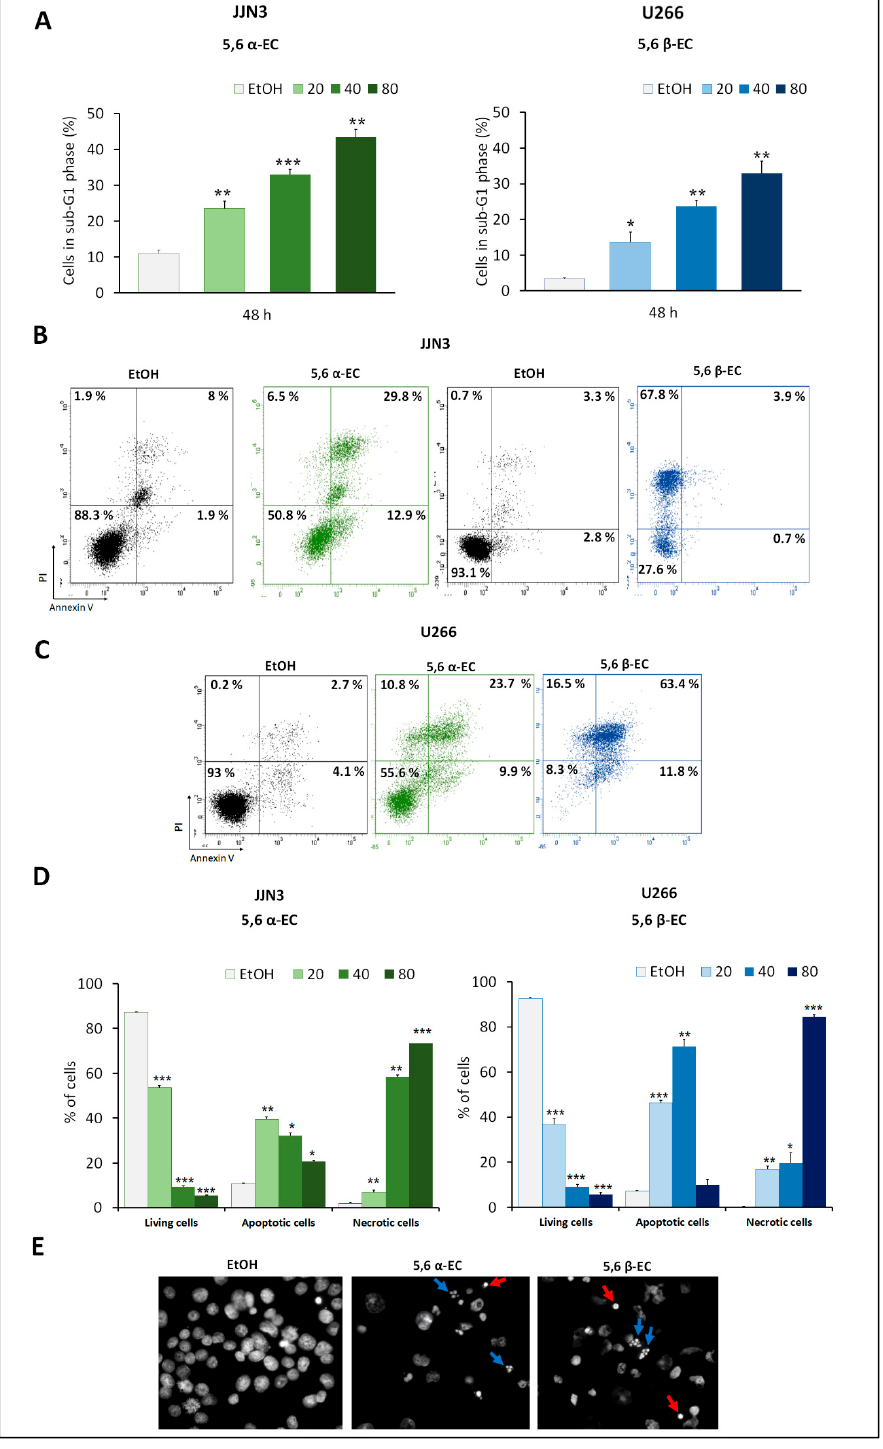
Figure 2. 5,6-ECs induce apoptosis of HMCLs. ( A ) JJN3 and U266 cells were seeded at the density